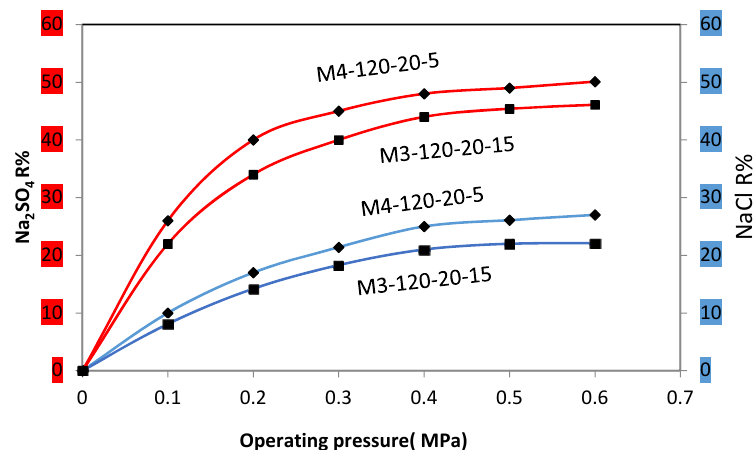
Fig. 10: Effect of operating pressure (MPa) and dip-coating parameter on the Rejection%. Fig.